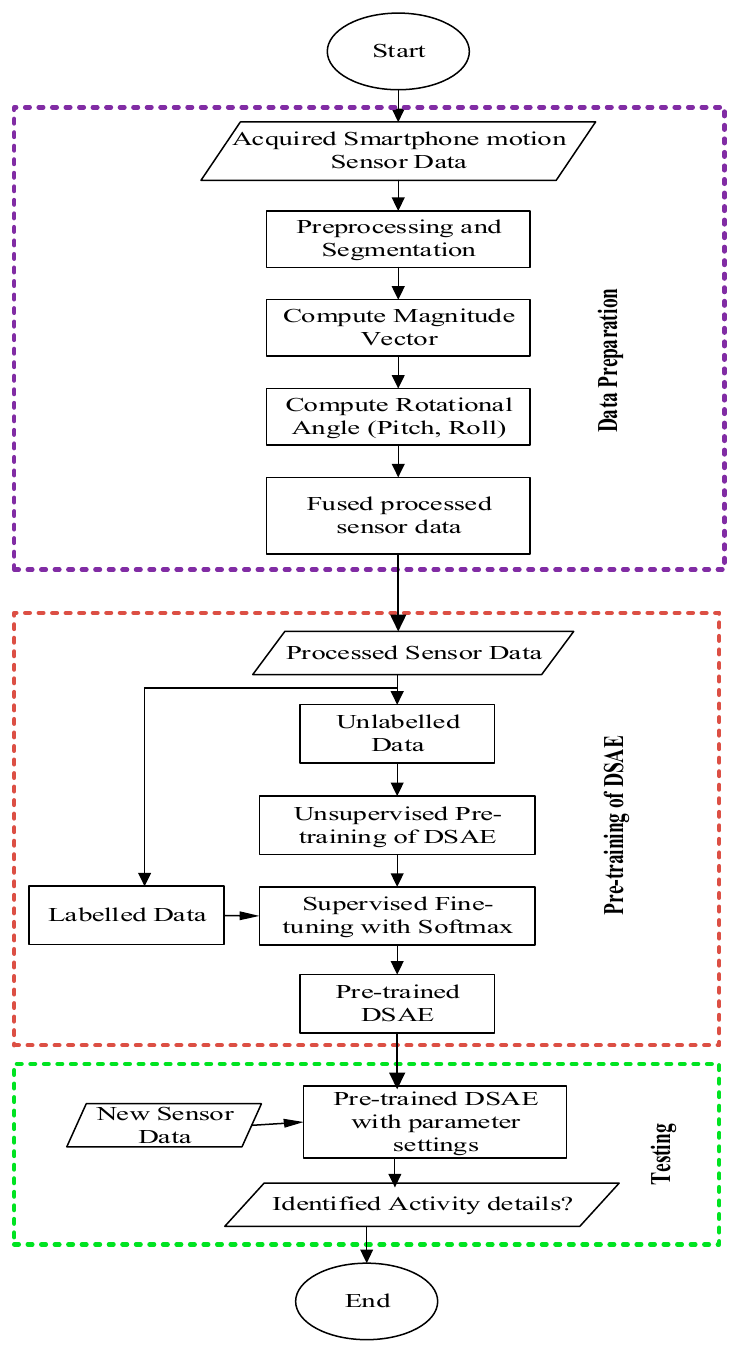
Figure 2. Flowchart of the proposed method.